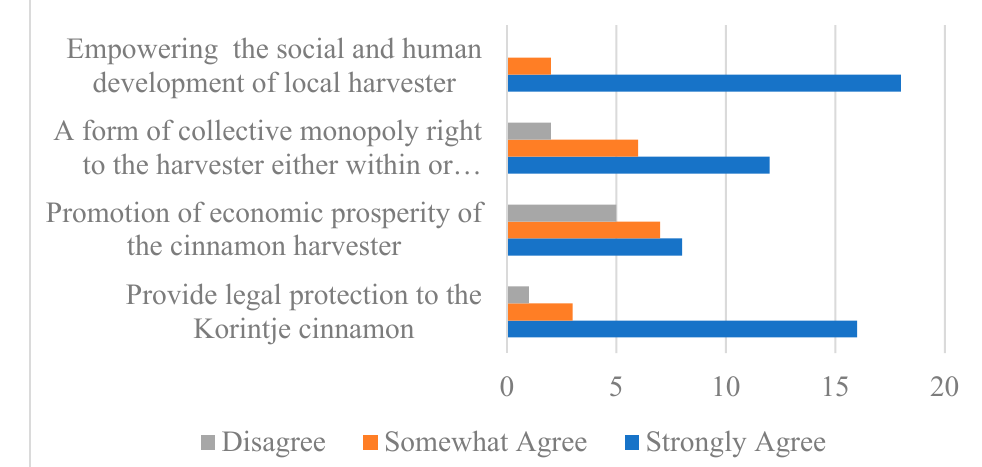
Figure 10. TAKTIK post-harvesting practice following the GI Koerintji handbook guideline.